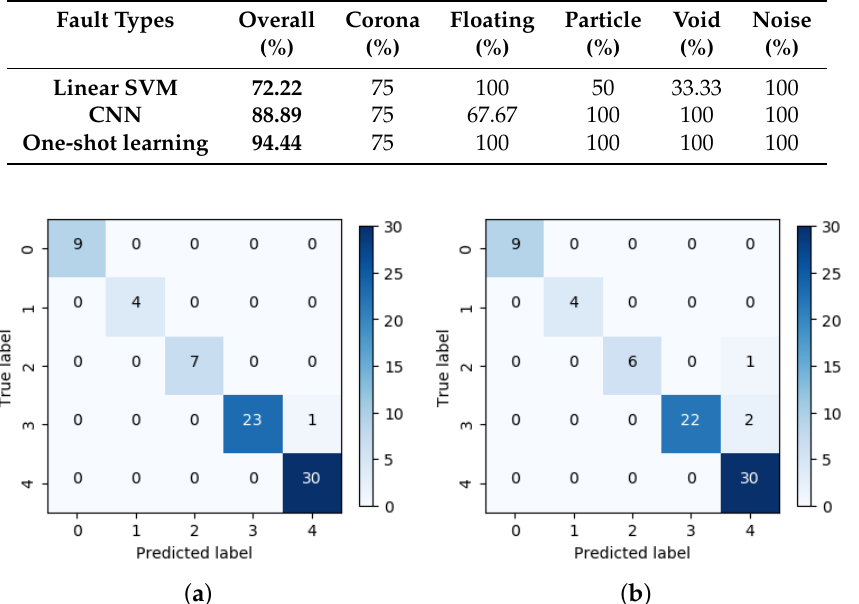
Table 4. Performance comparisons with balanced data case.